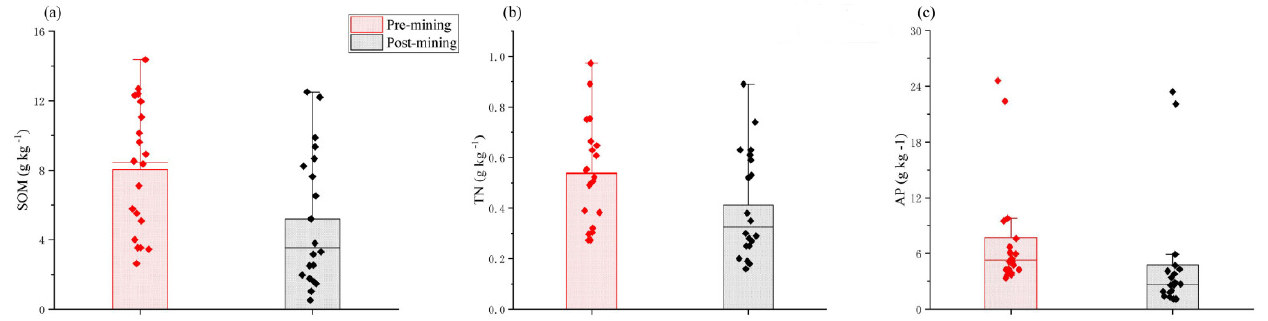
Figure 2. SOM ( a ), TN ( b ), and AP ( c ) content in pre-mining soil and post-mining soil. Table 1. Comparison between SOM, TN, and AP in pre-mining and post-mining soil using the paired t-test.